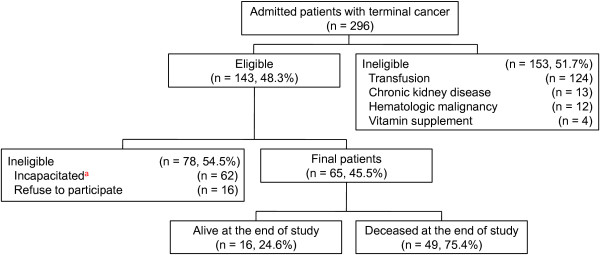
Flowchart of patient recruitment. aphysician-assessed.